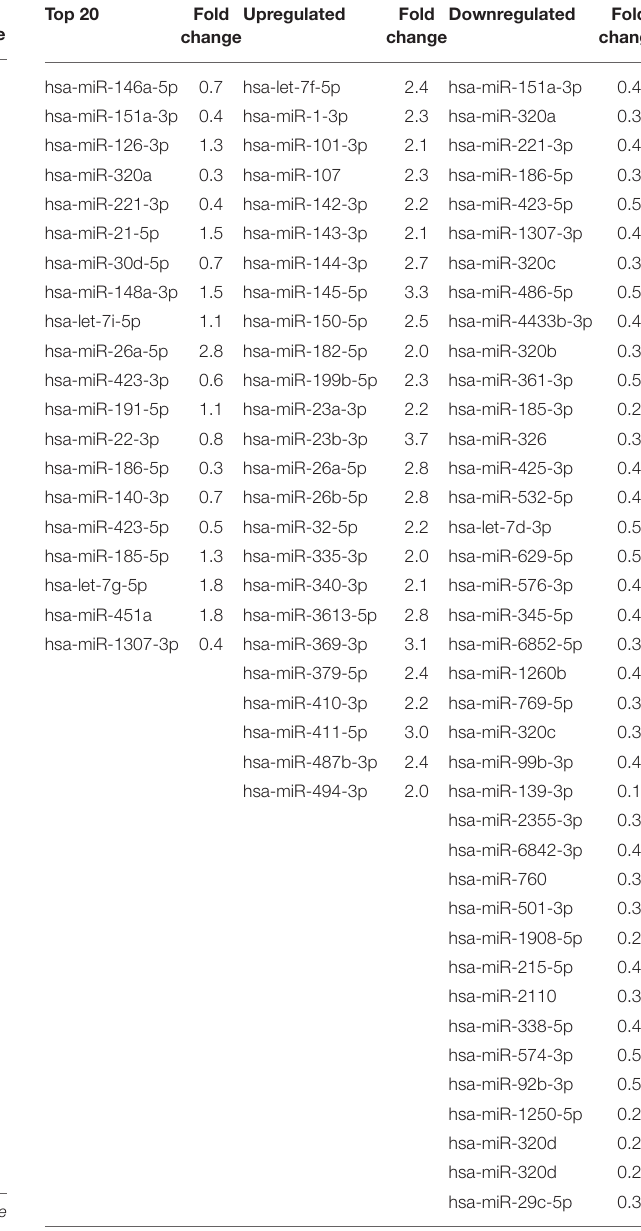
TABLE 2 | Impact of Additive solution treatment on the microRNA profile of platelet-derived MPs. Top 20 Fold changeUpregulated Fold changeDownregulated Fold